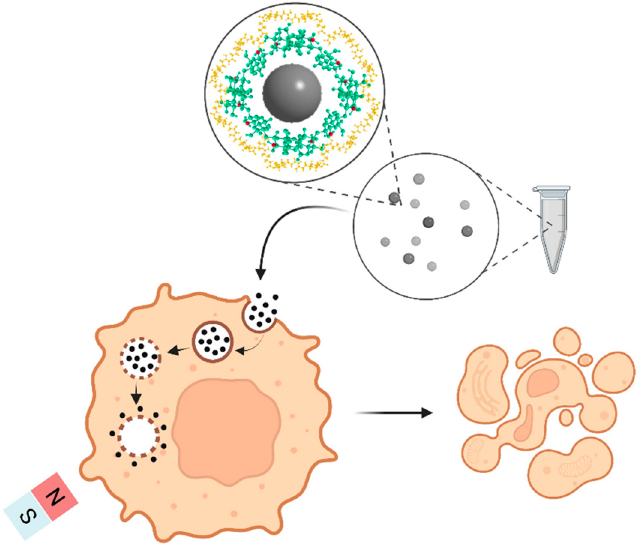
Figure 13. Schematic representation of the cellular uptake and cytotoxicity studies of the CUR-2GE- Ch-IONPs in MDA-MB-231 in the presence of the permanent magnet. Ch-IONPs in MDA-MB-231 in the presence of the permanent